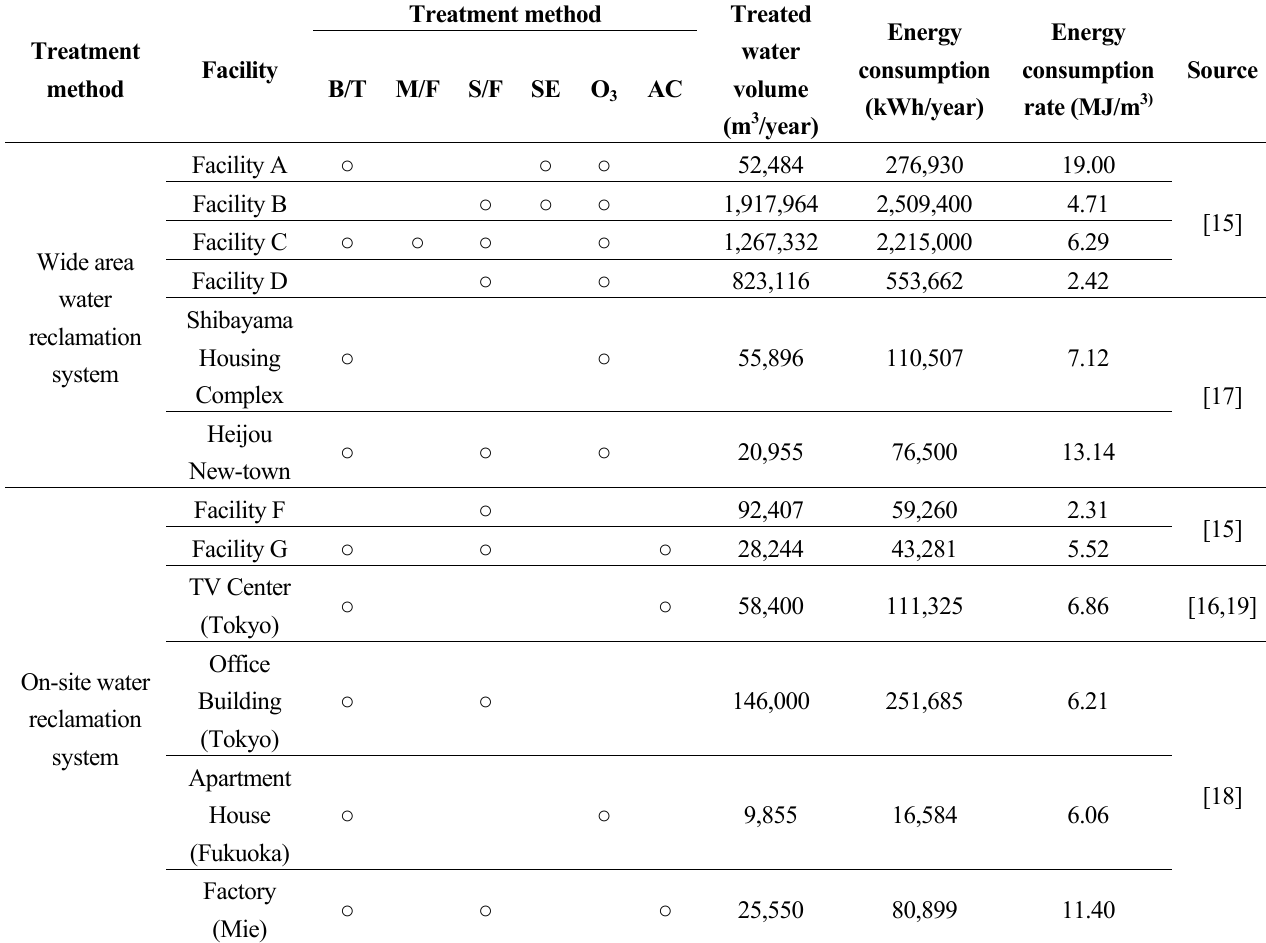
Table 4. Energy consumption for grey water treatment system in Japan.